Question: Give a one-sentence summary of this figure.
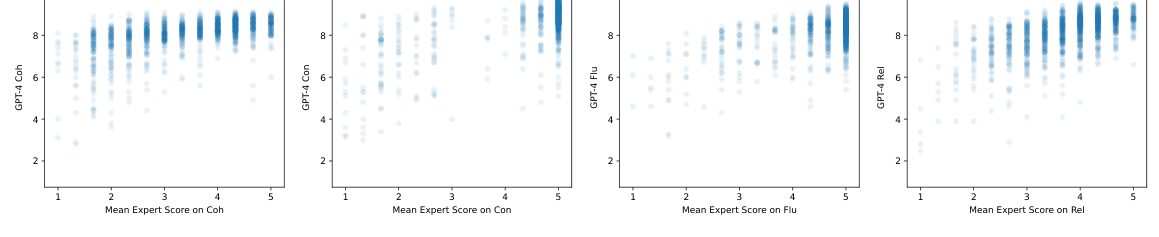
Answer: Scatter-plots of evaluated score versus expert judgements reveal that while many papers claim 0.40 τ is strong performance, the correlation with human judgements still needs substantial improvements. Even with correlation of over 0.40 Kendall’s τ, we notice that any individual evaluation may lie within a very wide range as compared to the ground-truth labeled by experts. Note that the full range of 1-10 is underutilized again.